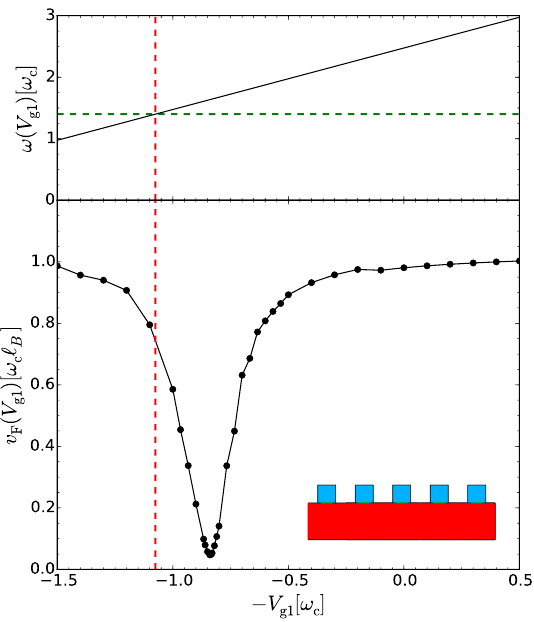
Figure 13: Upper panel: The horizontal dashed line shows the set Fermi level while the slanted solid lines depict the energy level in the isolated bays shifted by the gate voltage. The vertical red line is a guide to the eye to link the resonance visible in the upper panel to the strong response in the lower panel. Lower panel: Fermi velocity v as function of the gate voltage V F = 2 µ m, L = 10 µ m, L = 4.01 µ m, L = 1 µ m, and (cid:96) = 1 µ for L y x p B b o